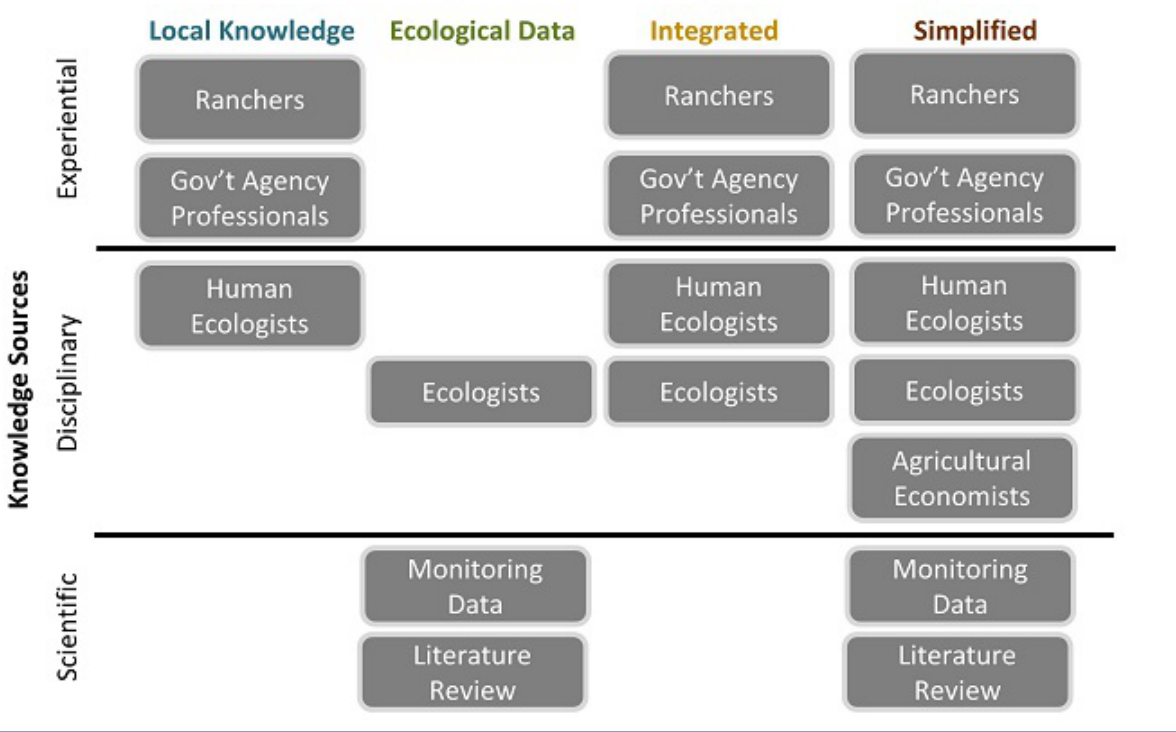
Fig. 3 . Contribution of different knowledge sources at different steps of the multidisciplinary state and transition model development process. At each step, an increasingly broad group of knowledge sources contributed to the